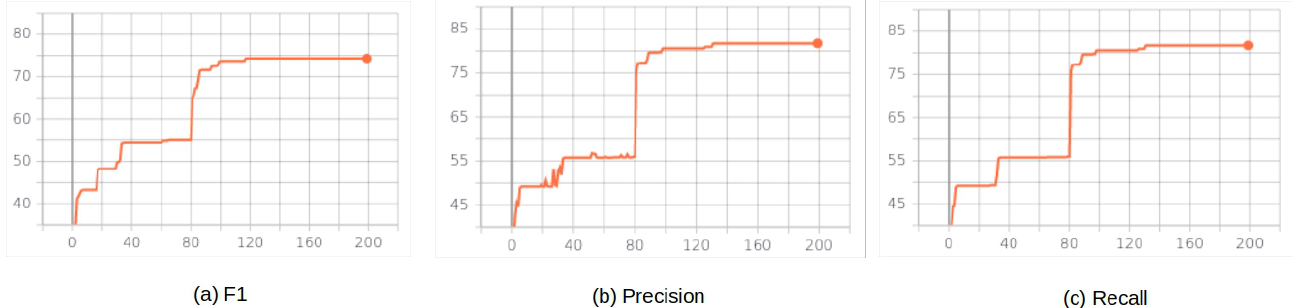
Figure 2. ( a ) F1, ( b ) Precision and ( c ) Recall metric plots showing the effect of switching the logit weight vector from ideal logic weight vector ˜ q to uniform logic weight vector ¯ q at Epoch 80.